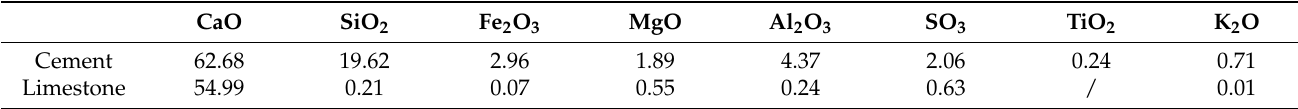
Table 1. Chemical composition of cement and limestone